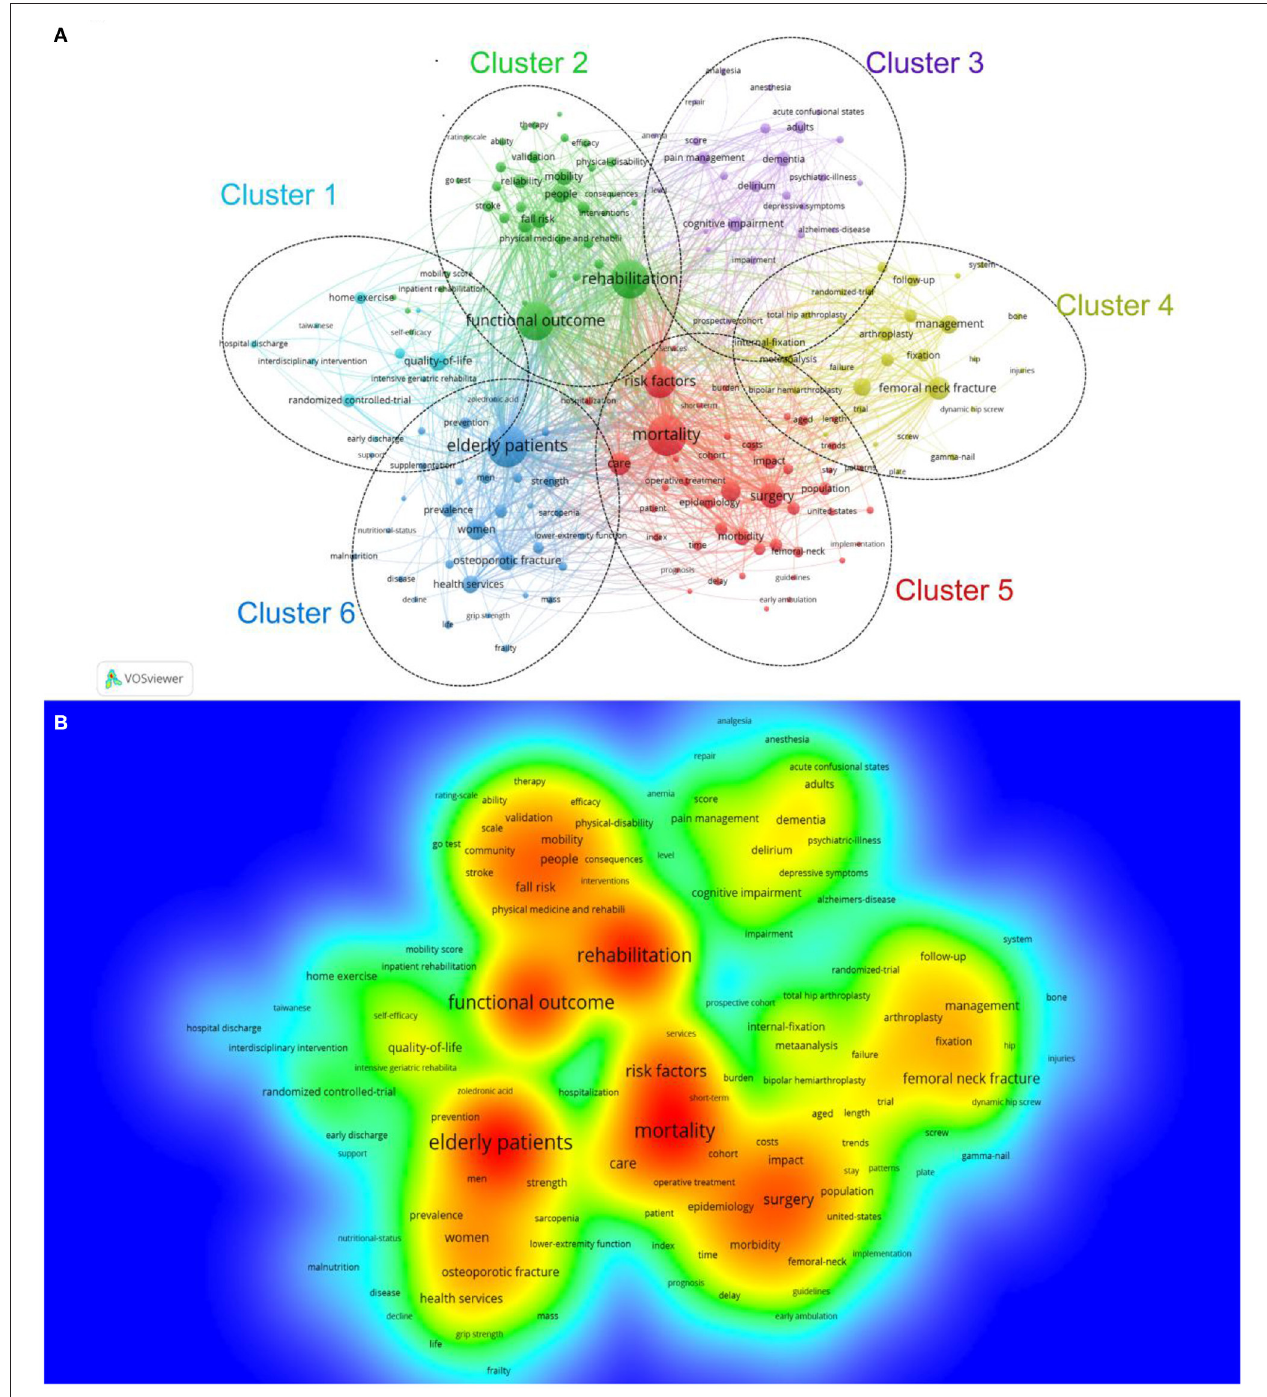
FIGURE 6 | (A) Network visualization of the keyword co-occurrence analysis by VOS viewer. (B) The density map of keywords.